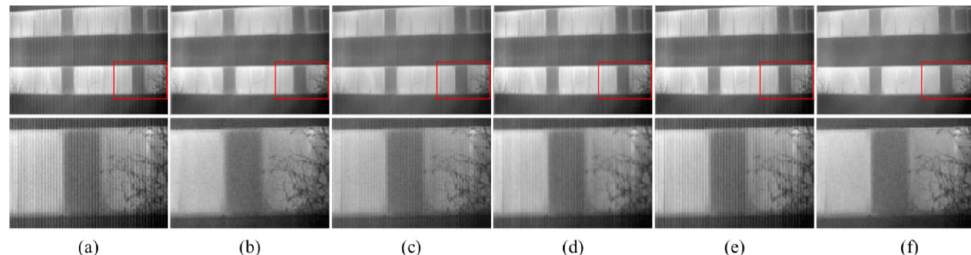
Figure 11. The NUC results of different methods. Top: raw infrared image and the NUC results; Bottom: Zoom-in views on the highlighted area. ( a ) The raw images; ( b ) 1DGF [33]; ( c ) SNRCNN [15]; ( d ) DLS-NUC [16]; ( e ) ICSRN [17]; ( f ) Our method.